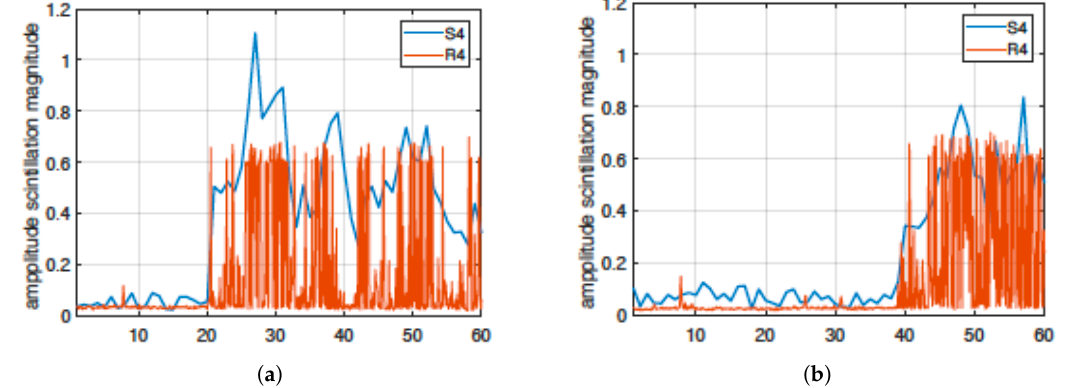
Figure 9. Comparison of S 4 and R 4 parameters: ( a ) GPS PRN 1, ( b ) GPS PRN 3.